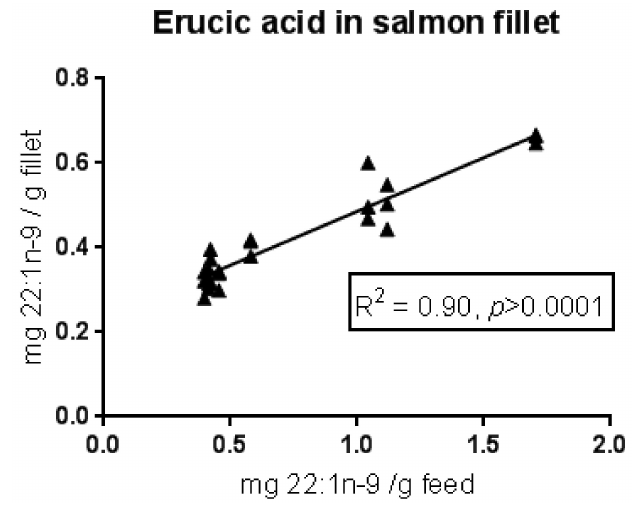
Figure 3. Content of erucic acid (22:1n-9) in salmon fillet in relation to dietary content of erucic acid, in a feeding trial with Atlantic salmon [10] given eight experimental feeds ranging from 40–170 mg erucic acid/100 g feed. The adjusted R -value and the p -value for a linear regression model are given. In the polar lipids (cell membranes) of the heart, the content of erucic acid was mainly